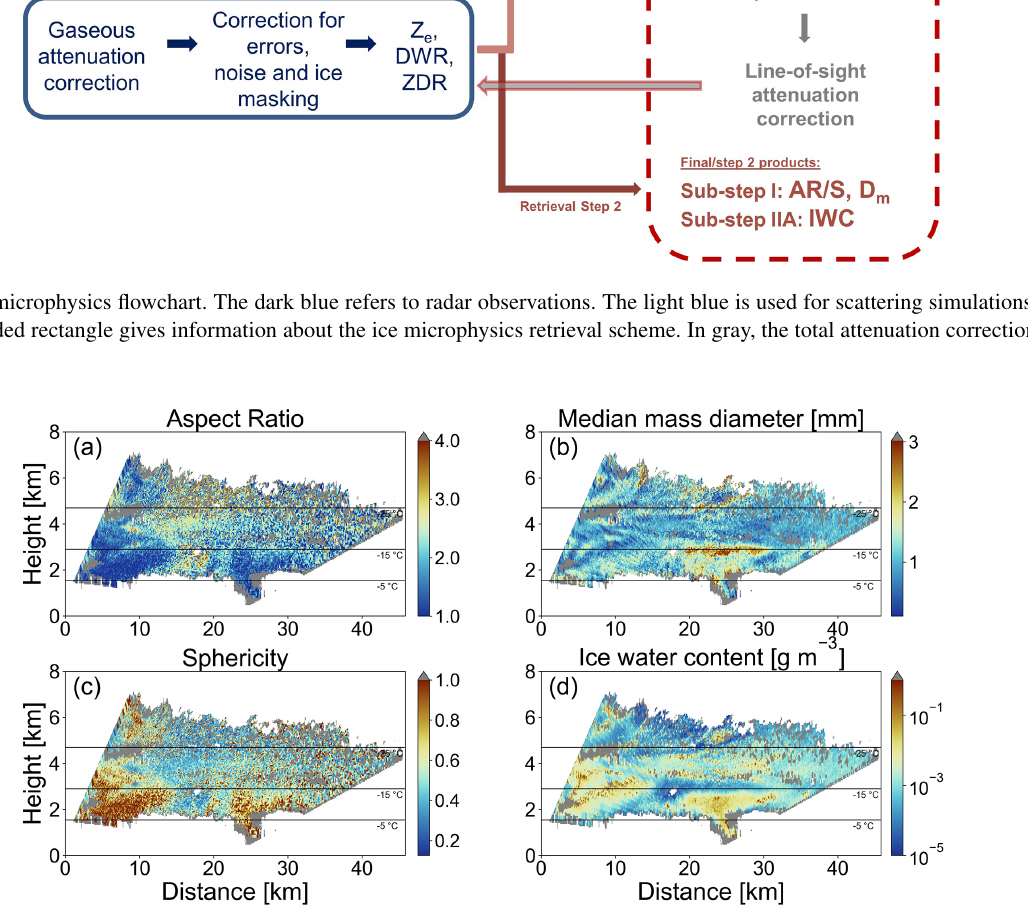
Figure 11. Retrieved (a) AR, (b) D m , (c) S , and (d) IWC for 30 January 2019 at 10:08UTC with ice spheroids assumed to be oblates and their m(D max ) corresponding to aggregates from Yang et al. (2000). The − 5, − 15, and − 25 ◦ C temperature levels are plotted with black solid lines (source: Deutscher Wetterdienst, data provided by University of Wyoming; http://weather.uwyo.edu/upperair/sounding.html, last access: 8 April 2022). Areas where ice-masked and noise-filtered measurement values are located are plotted with